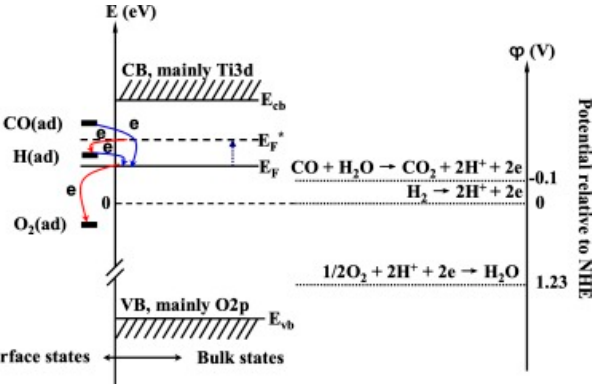
Figure 18. Schematic energy level characterizing the surface and bulk electronic states of TiO 2 , as well as the oxidation potential value of CO and H 2 . The adsorption of H 2 causes the elevation of Fermi level (from EF to EF* (a quasi-Fermi level)) under UV irradiation, resulting in H 2 accepting electrons from TiO 2 , while CO still donate electrons to TiO 2 . Reproduced with permission from [52].